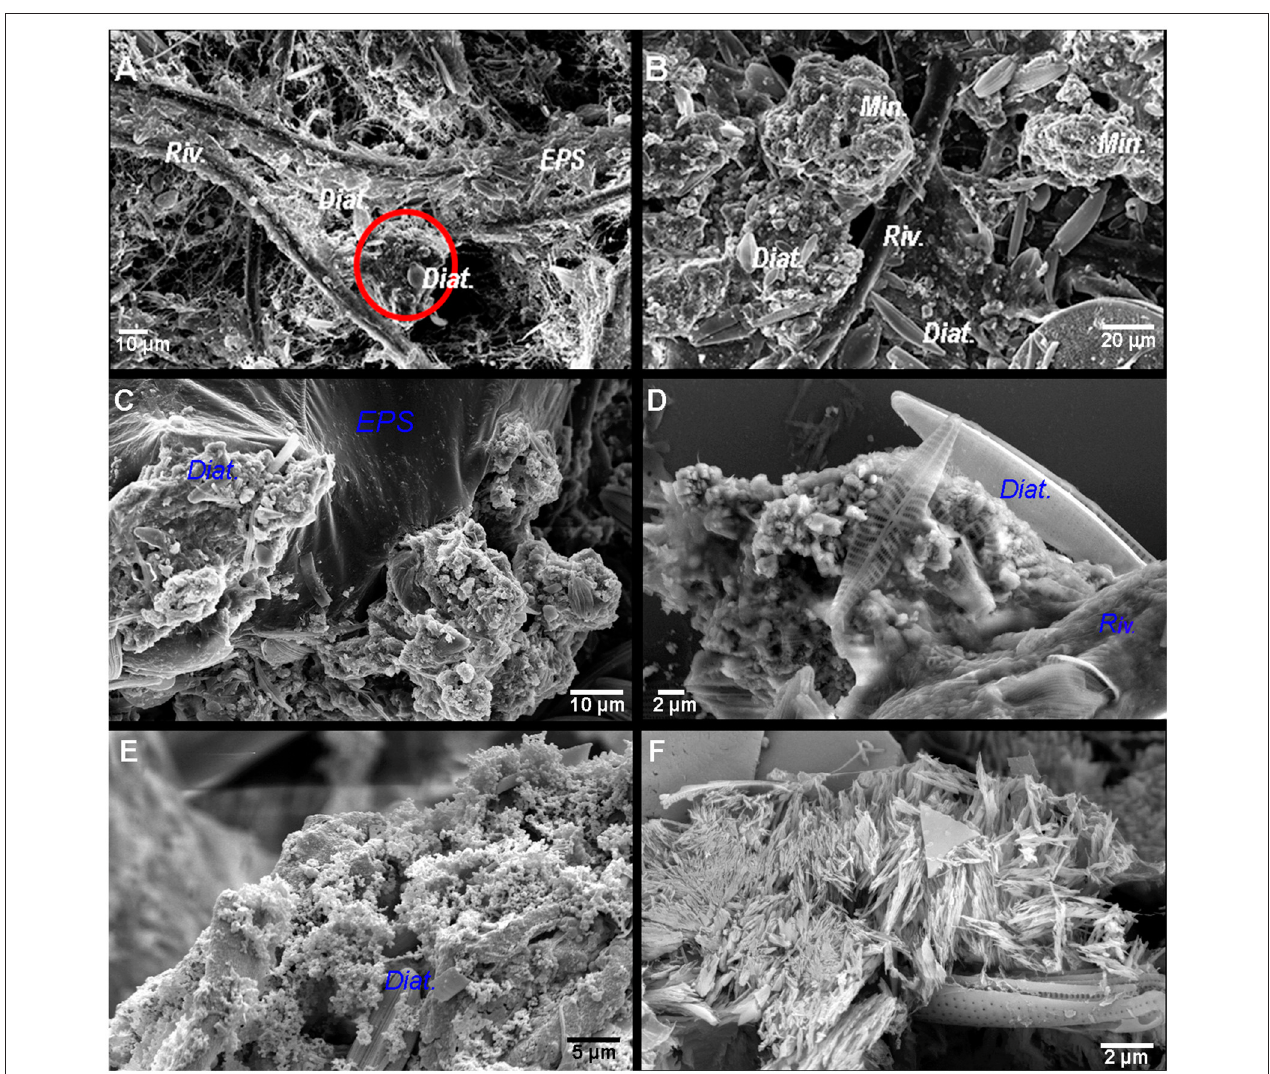
FIGURE 6 | (A) SEM images of the surface of the black pustular mat where Rivularia filaments ( Riv. ) and exopolymeric substances ( EPS ) are observed. The red circle highlights a mineral aggregate with diatoms ( Diat. ). (B) Below the black pustular surface, mineral aggregates ( Min. ) with diatoms are abundant; some Rivularia filaments can also be observed. From (C–D) , SEM images in backscattered electron mode of the carbonate minerals associated with the Rivularia filaments in BP mats. (C) Aggregates formed by sub-spherical to subhedral carbonate particles associated with the EPS matrix where diatoms frustules are also observed. (D) Magnified view of a mineral aggregate with subspherical carbonate grains and associated diatoms. (E) Aggregate composed of submicrometric carbonate spherules entombing abundant diatoms frustules. (F) Elongated needle-like